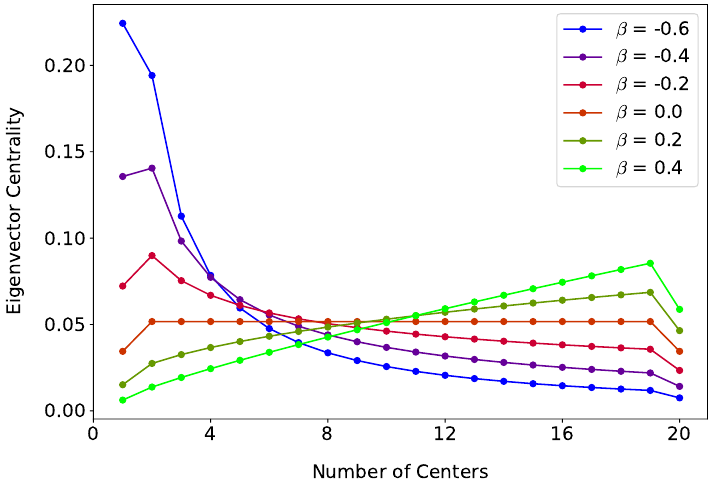
Figure 7: The eigenvector centrality for different values of β when δ = 0 and = N max